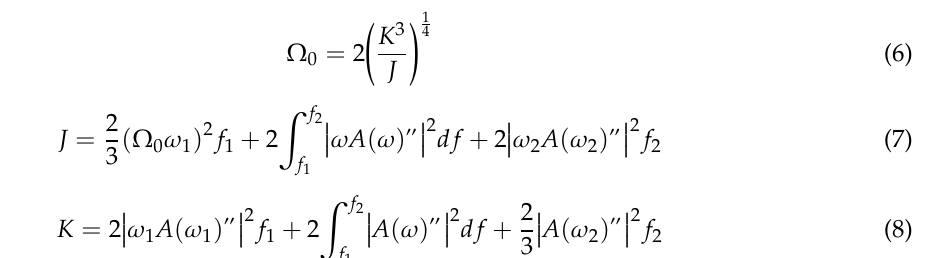
Figure 9. Measured and calculated Fourier amplitude spectrum (FAS) at three sample stations: (a) BUS2 station, (b) CEA station, (c) CEJA station. 3.2. Shaping Window Model Estimation In order to generate a ground acceleration in the time domain (